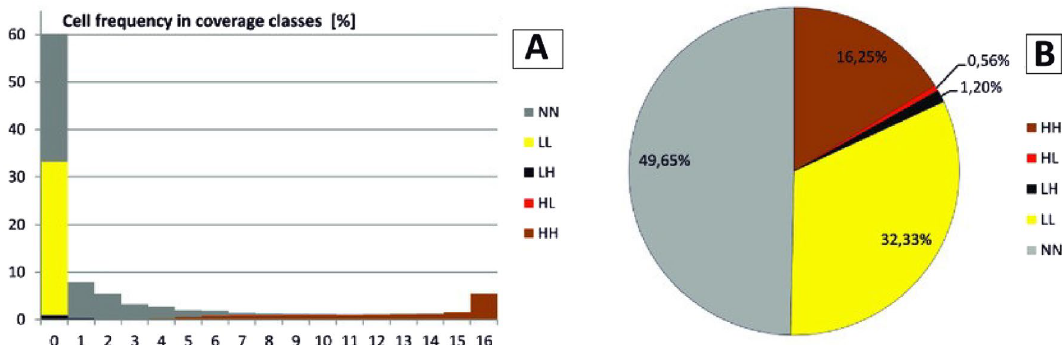
Figure 4. ( A ) Distribution of the frequency of grid cells (20 × 20 m) depending on the scrub coverage in 16 cover-classes; (B) The percentage of cluster type according to the Anselin Local Moran’s I statistic. HH—cell clusters with high coverage (hot spots), LL—cell clusters without scrub or low coverage values (cold spots), HL—cells with high values, outliers from the background with low values, LH—cells with low values, outliers from the background with high values (both statistically significant spatial outliers), NN—cells with no significant spatial relations. For the details of the calculations see Supplementary Information—Appendix. Credit: ArcMap